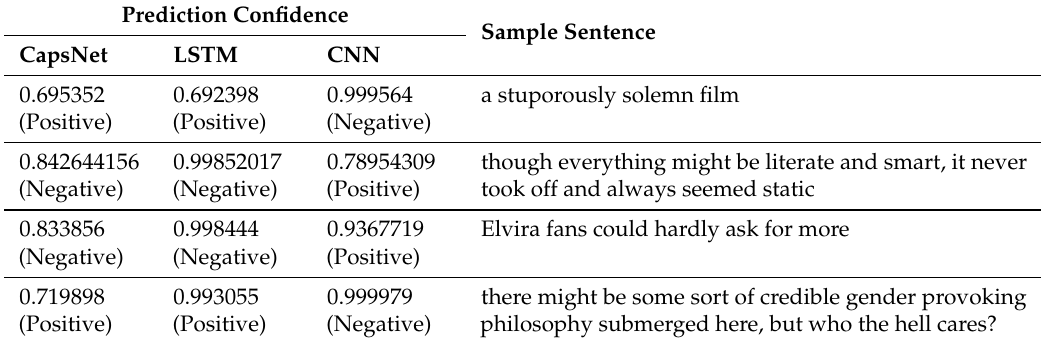
Table 7. Sample sentences incorrectly predicted by CapsNet but correctly predicted by